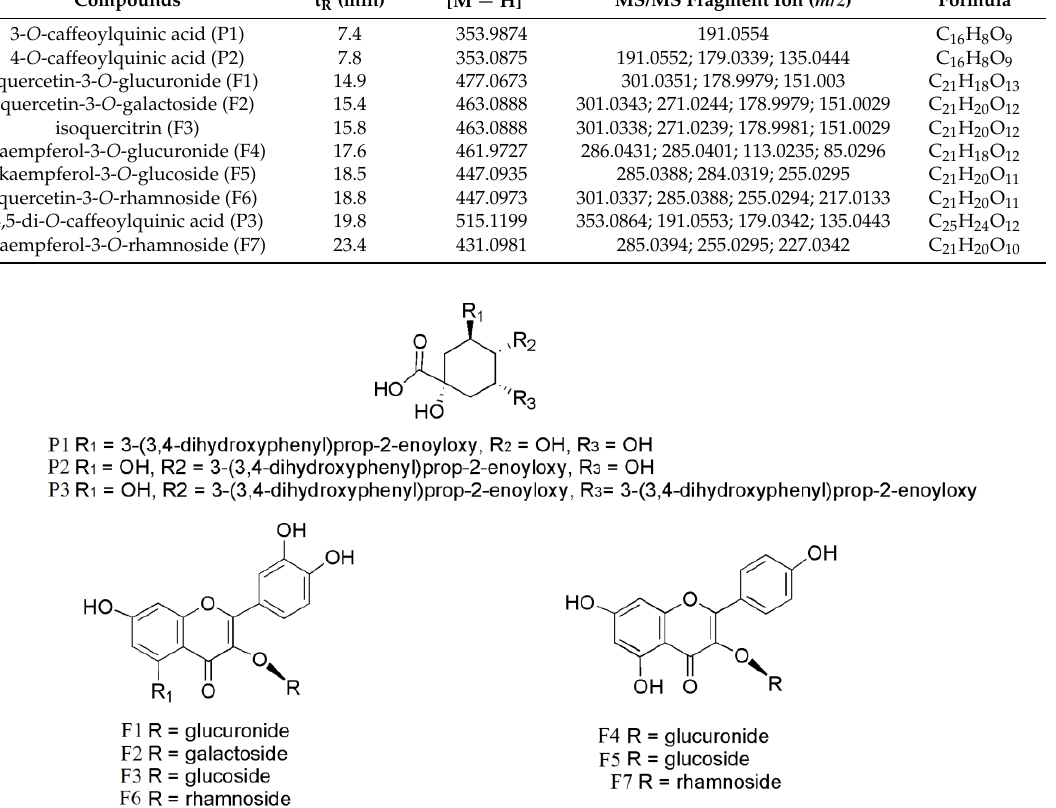
Figure 1. Chemical structures of the 10 quantitative compounds in leaves of C. paliurus : (1) 3- O -caffeoylquinic quercetin-3- O -galactoside; (5) isoquercitrin; (6) kaempferol-3- O -glucuronide; (7) kaempferol 3- O -glucoside; kaempferol-3- O -rhamnoside. Table 2. Phenolic contents in C. paliurus from sampling locations (JZS, MC, WF, MW, and SN) (mg/g, mean ± SD). JZS from Jinzhongshan, Guangxi province; MC from Muchuan, Sichuan province; WF from Wufeng, Hubei province; MW from Meiwu, Zhejiang province; SN from Suining, Hunan province. Different letters indicate significant differences ( p < 0.05 by Duncan’s test) between locations ( n = 3) (nd, not detected).